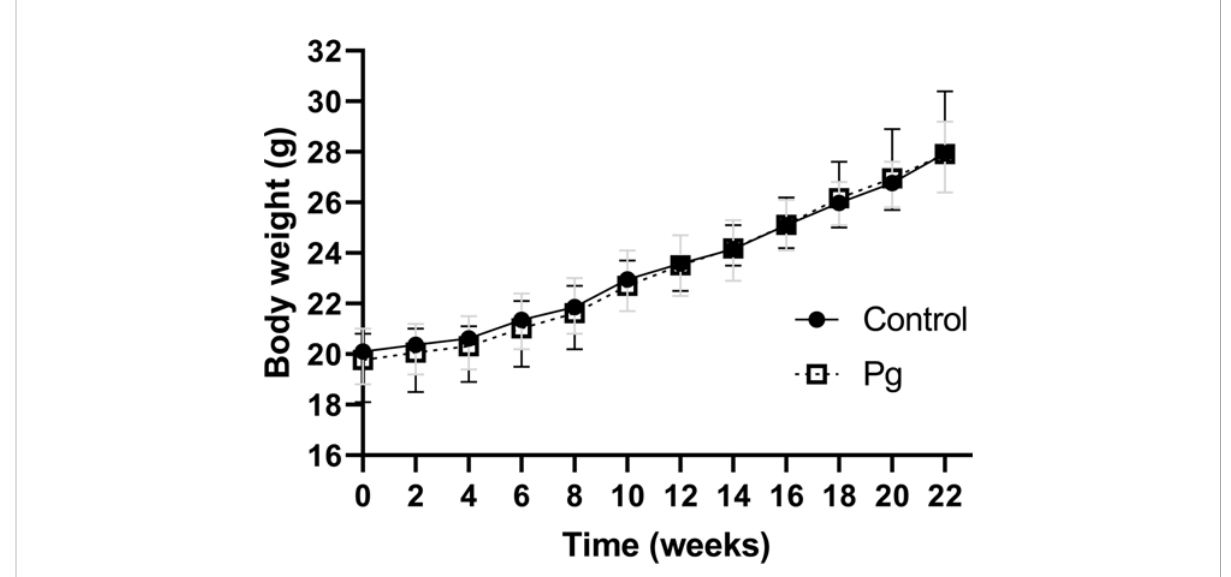
FIGURE 1 Effects of the oral administration of Porphyromonas gingivalis on body weight. Body changes during the experimental period in the control group ( N = 6) and the P. gingivalis -administered group ( N = 6) were measured. All data for each time point are expressed as the mean ±